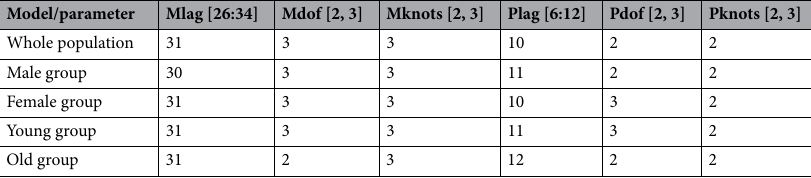
Table 2. Parameter optimization results based on qAIC value for different groups.